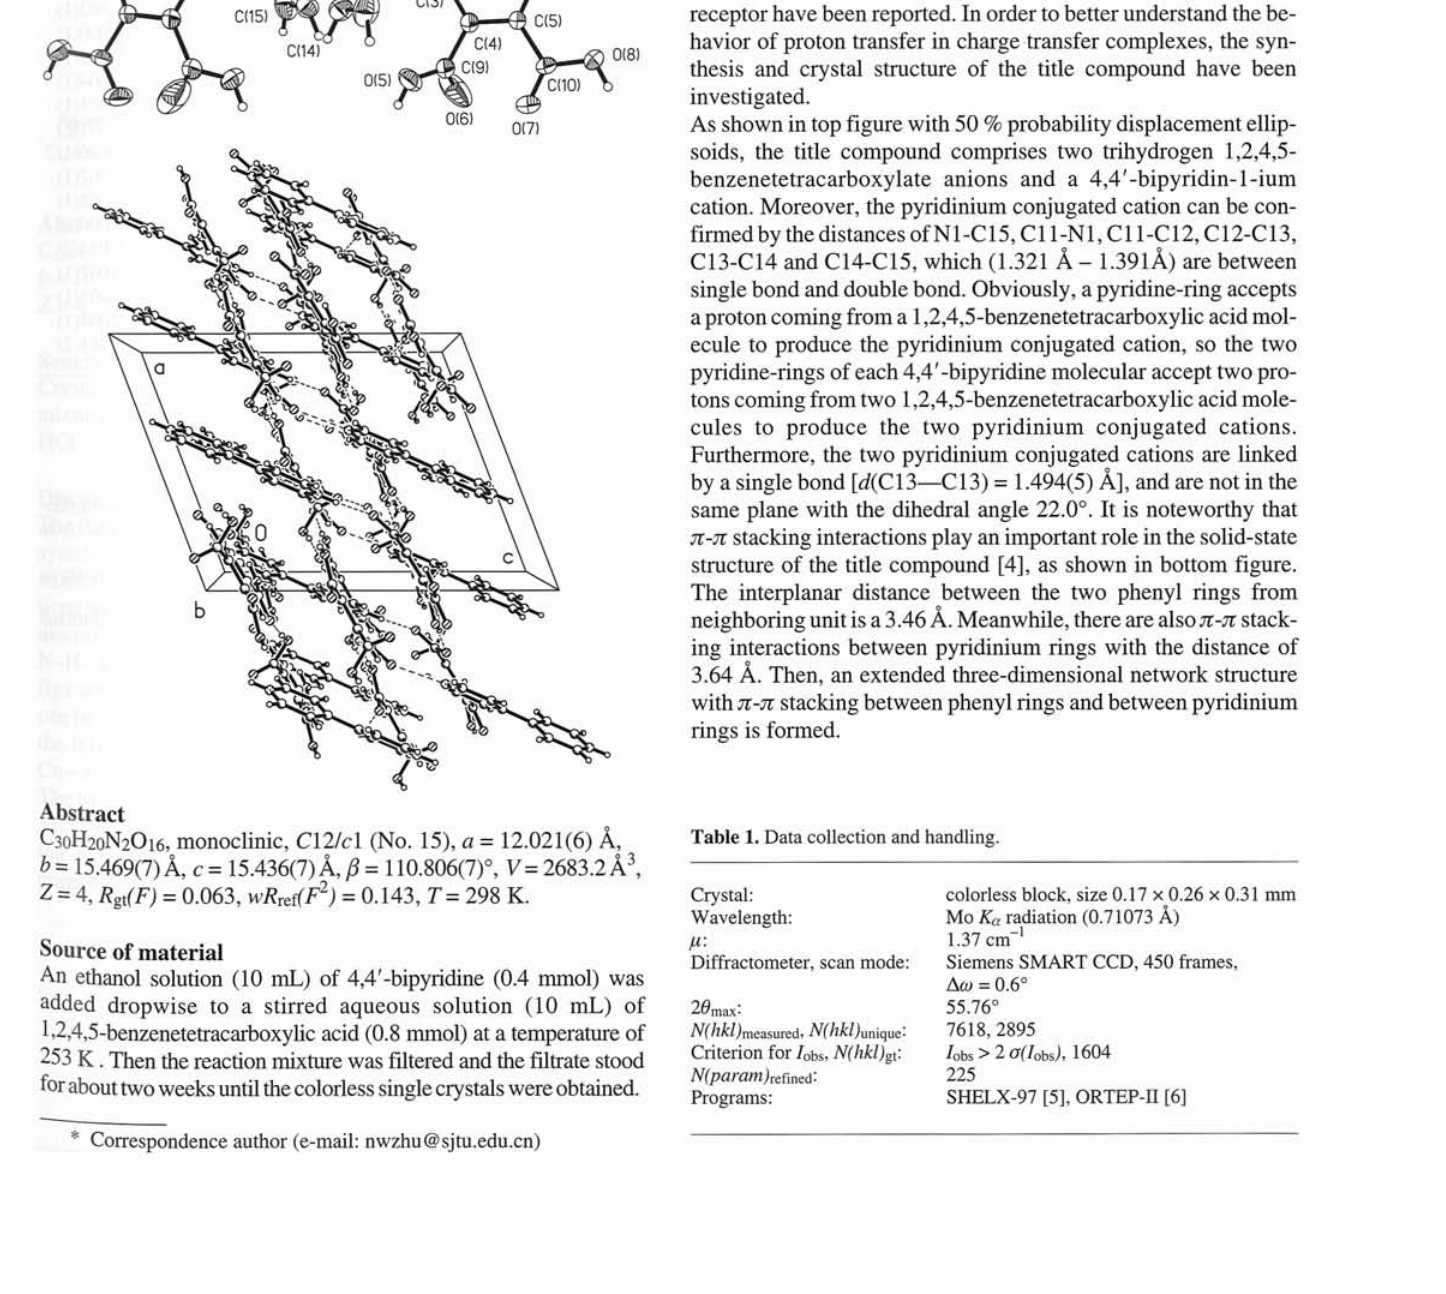
Table 1. Data collection and